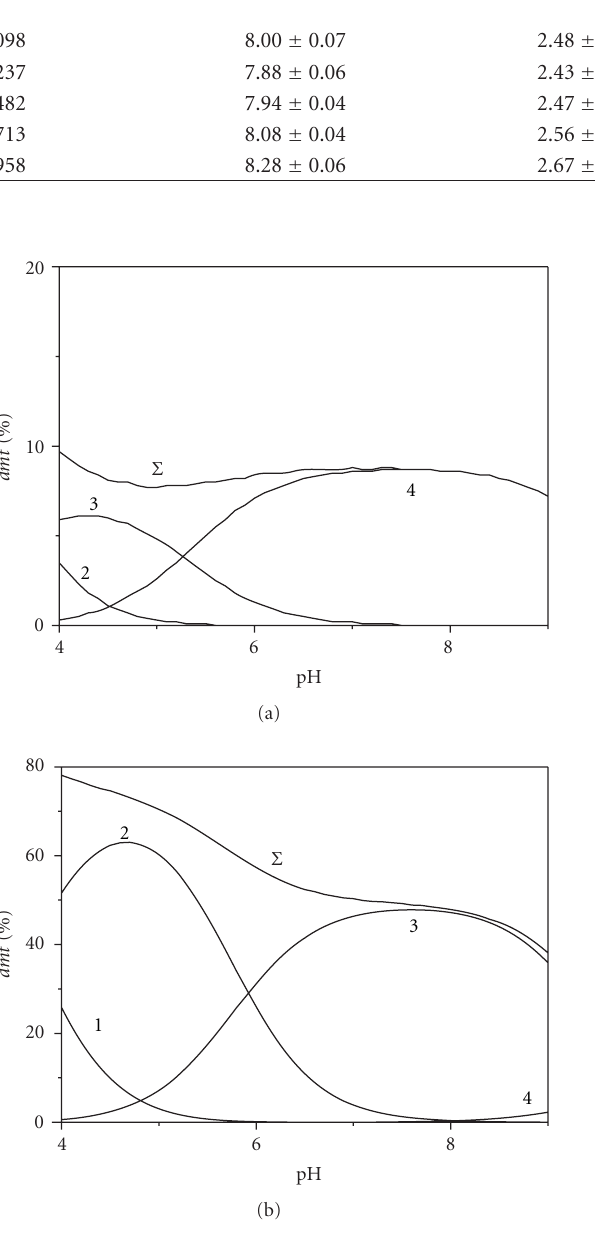
Figure 2: Distribution diagrams of dimethyltin(IV)/aminoacid species versus pH in NaCl aq at t = 25 ◦ C. Diagrams: (a) glycinate; (b) L -lysinate. Species: (1) MLH 2 ; (2) MLH; (3) ML; (4) MLOH. Charges omitted for simplicity. Experimental conditions: C dmt = 0 . 003 mol L − 1 , C L = 0 . 005 mol L − 1 ; I = 0 . 1 mol L − 1